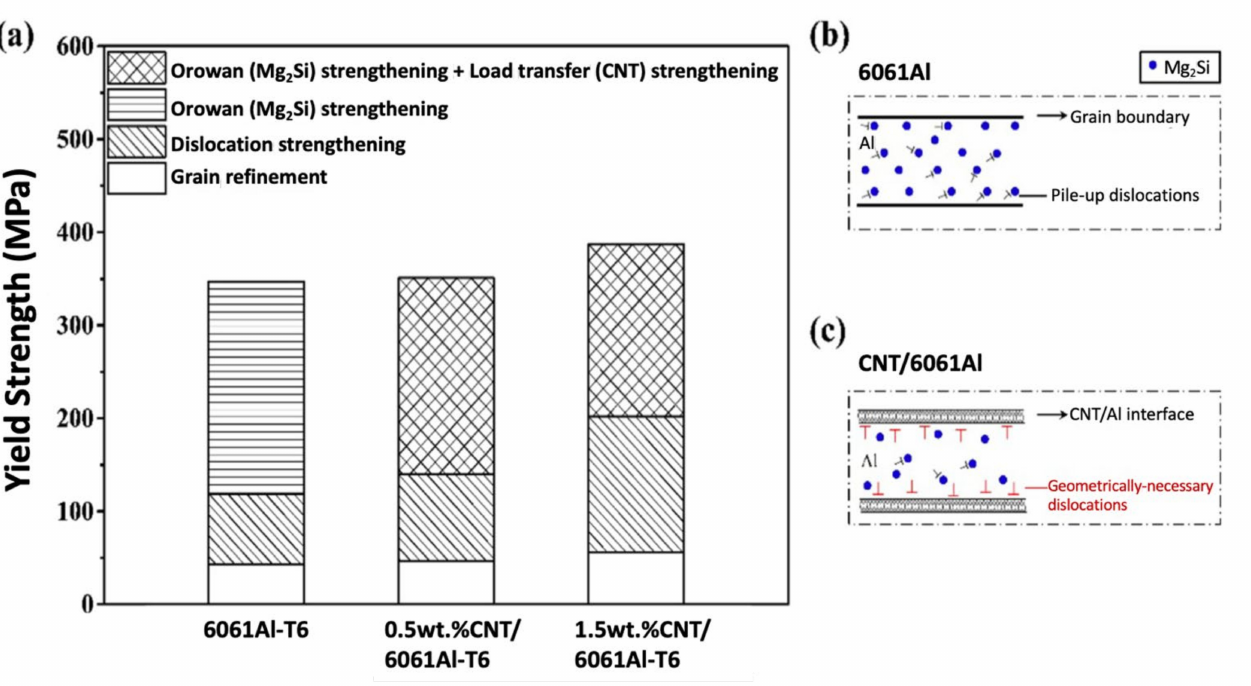
Figure 23. ( a ) Calculated yield strength contribution from grain refinement, dislocation strengthening, Orowan strengthen- ing, and load transfers strengthening; ( b ) and ( c ) illustration of the origin of the strengthening mechanisms in a 6061 alloy and 6061Al/CNT composites. Adapted from [98] with permission from Elsevier,